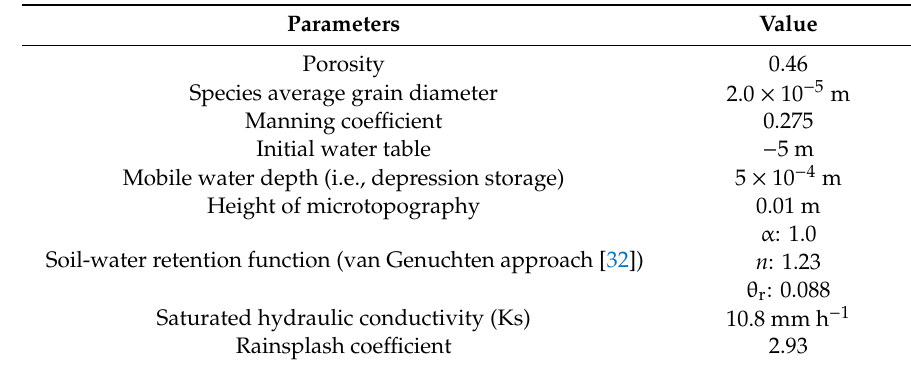
Table 1. Parameters for the simulation.